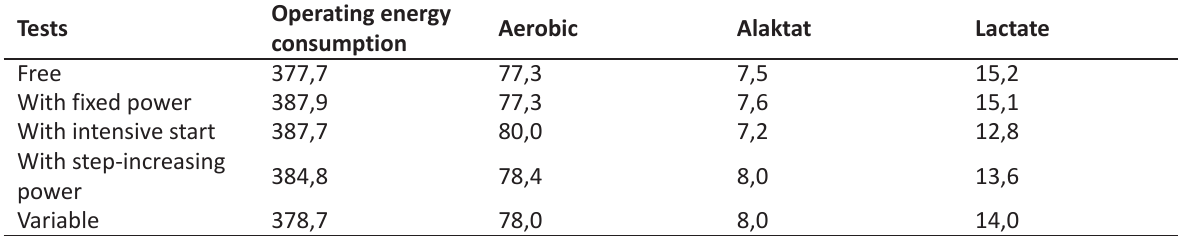
Table 2. Individual ranking of indicators of the performed work (I, II, III, IV) and economy (1, 2, 3, 4, 5)